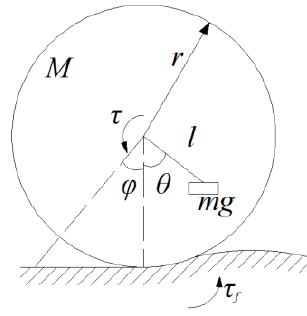
Figure 1. Diagram of Spherical Robot in Linear Motion.